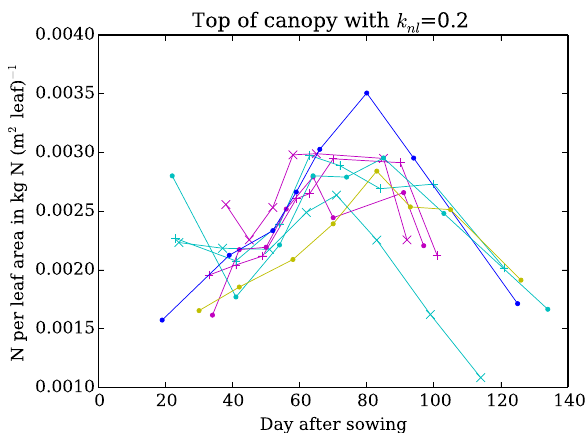
Figure 16. Observed leaf nitrogen per leaf area at top of canopy against day after sowing assuming a decay through the canopy with decay constant k nl = 0 . 2. Dots, vertical crosses (+) and diagonal crosses (x) are US-Ne1, US-Ne2 and US-Ne3 respectively. The years 2001–2004 are magenta, blue, cyan and